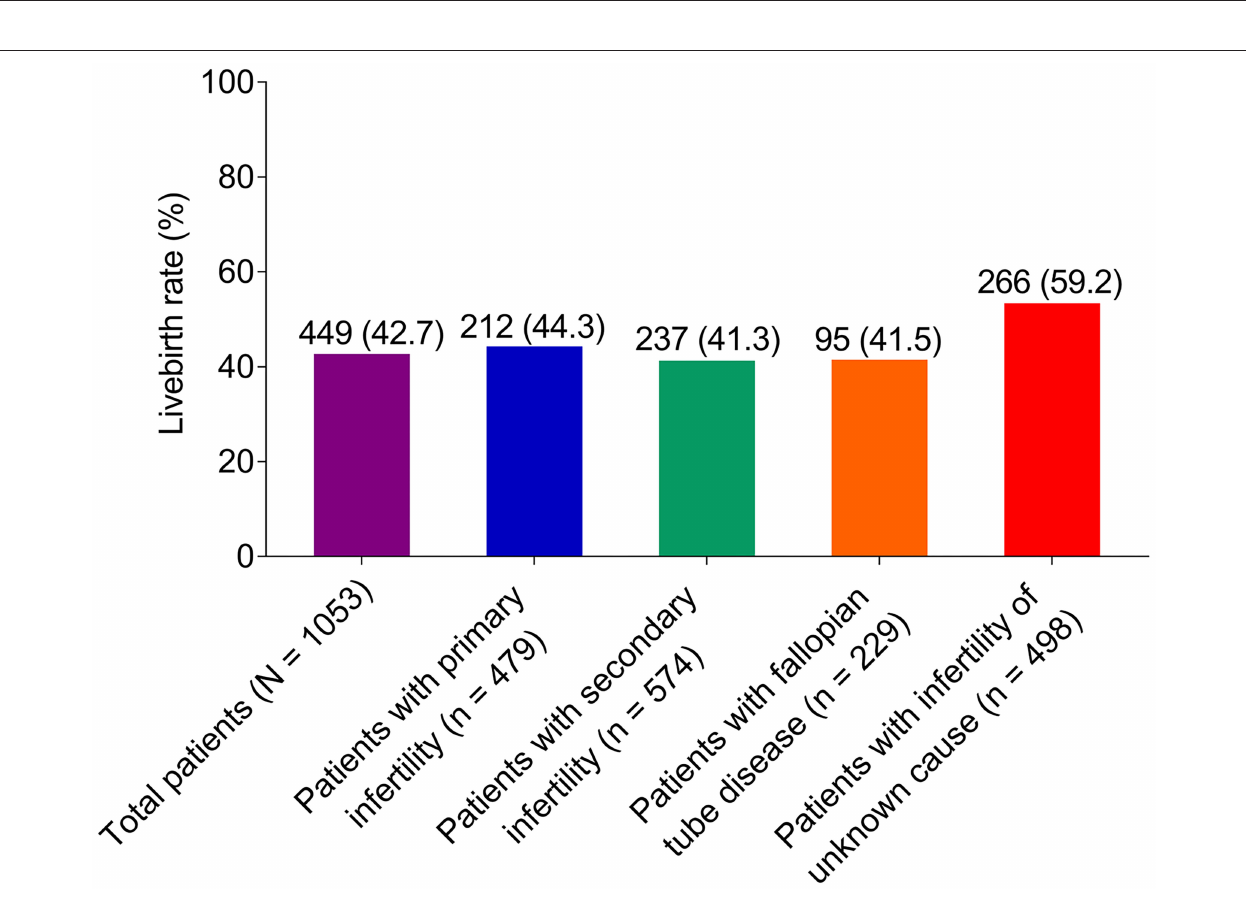
Frontiers in Medicine | www.frontiersin.org